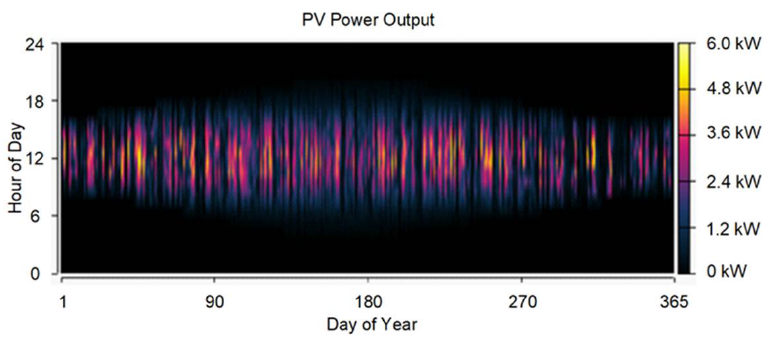
Figure 22. Overview of the energy produced from RES at the given hour.